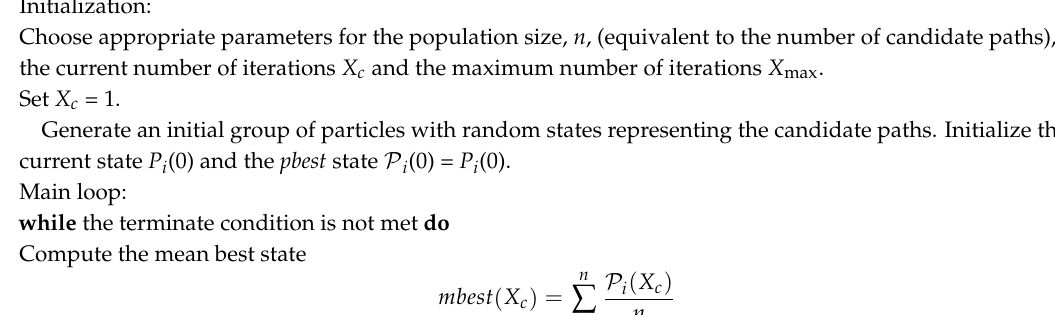
Algorithm 2. Lower level